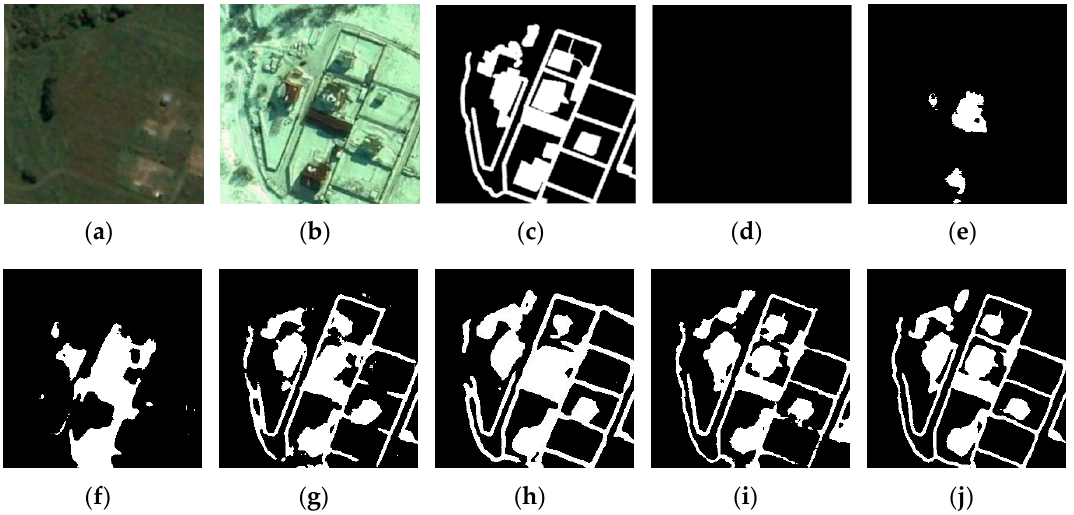
Figure 10. Visual comparison of change detection results in area 5: ( a ) T1 image, ( b ) T2 image, ( c ) ground truth, ( d ) FC-EF,